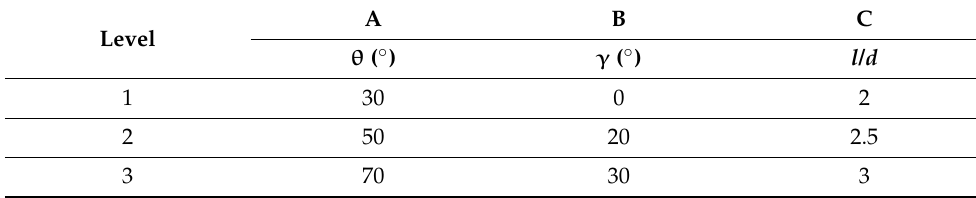
Table 3. Level table of each